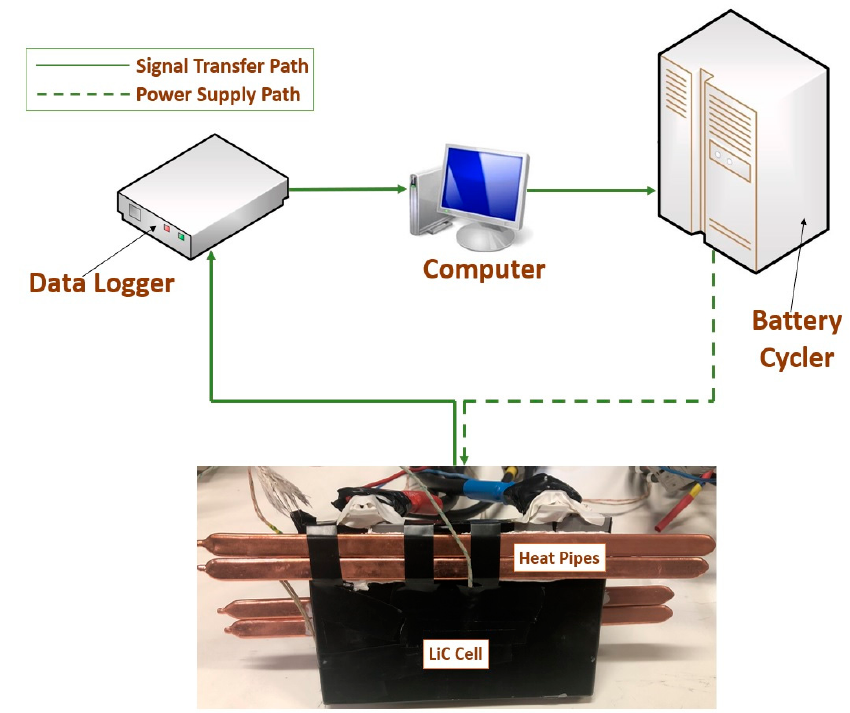
Figure 2. The schematic of the experimental test bench for the LiC cell.